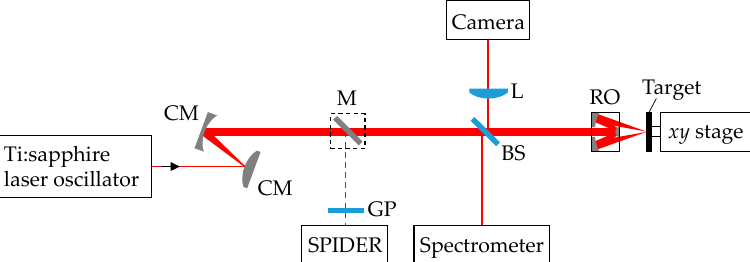
Figure 1. Schematic diagram of optical configuration for nanostructure formation. CM, convex or concave mirror; M, mirror; GP, glass plate; BS, beam splitter; L, lens; RO, reflective objective.